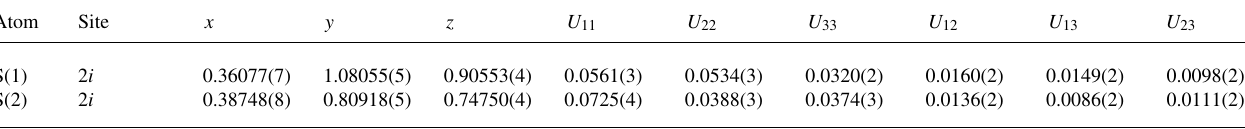
Table 3. Atomic coordinates and displacement parameters (in Å 2 )